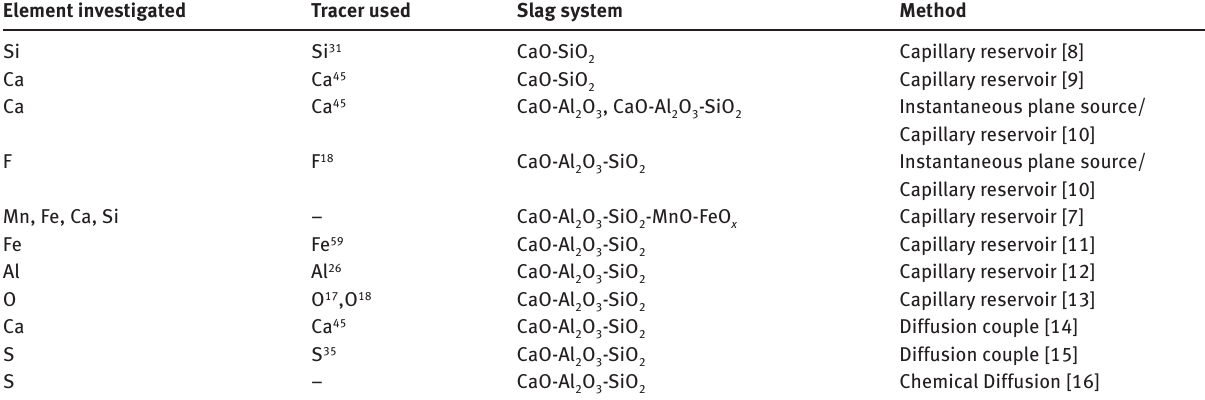
Table I: Details of elements investigated along with the slag system used and diffusion